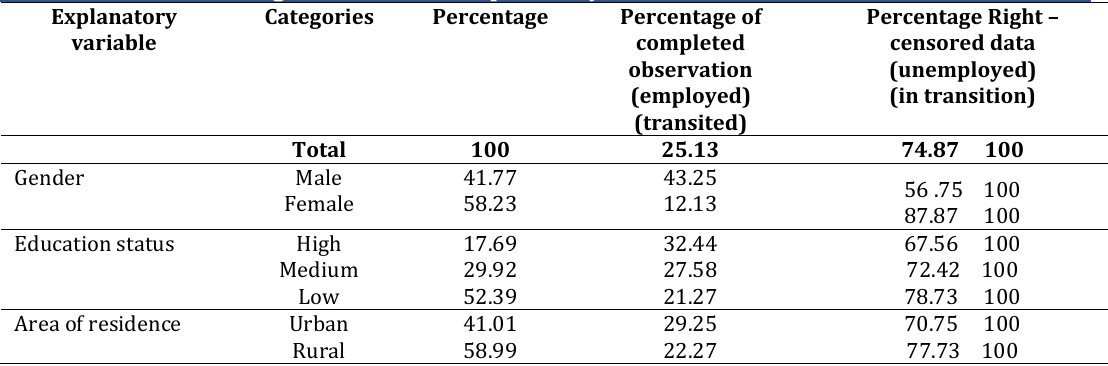
Table 10: Different categories of chosen explanatory